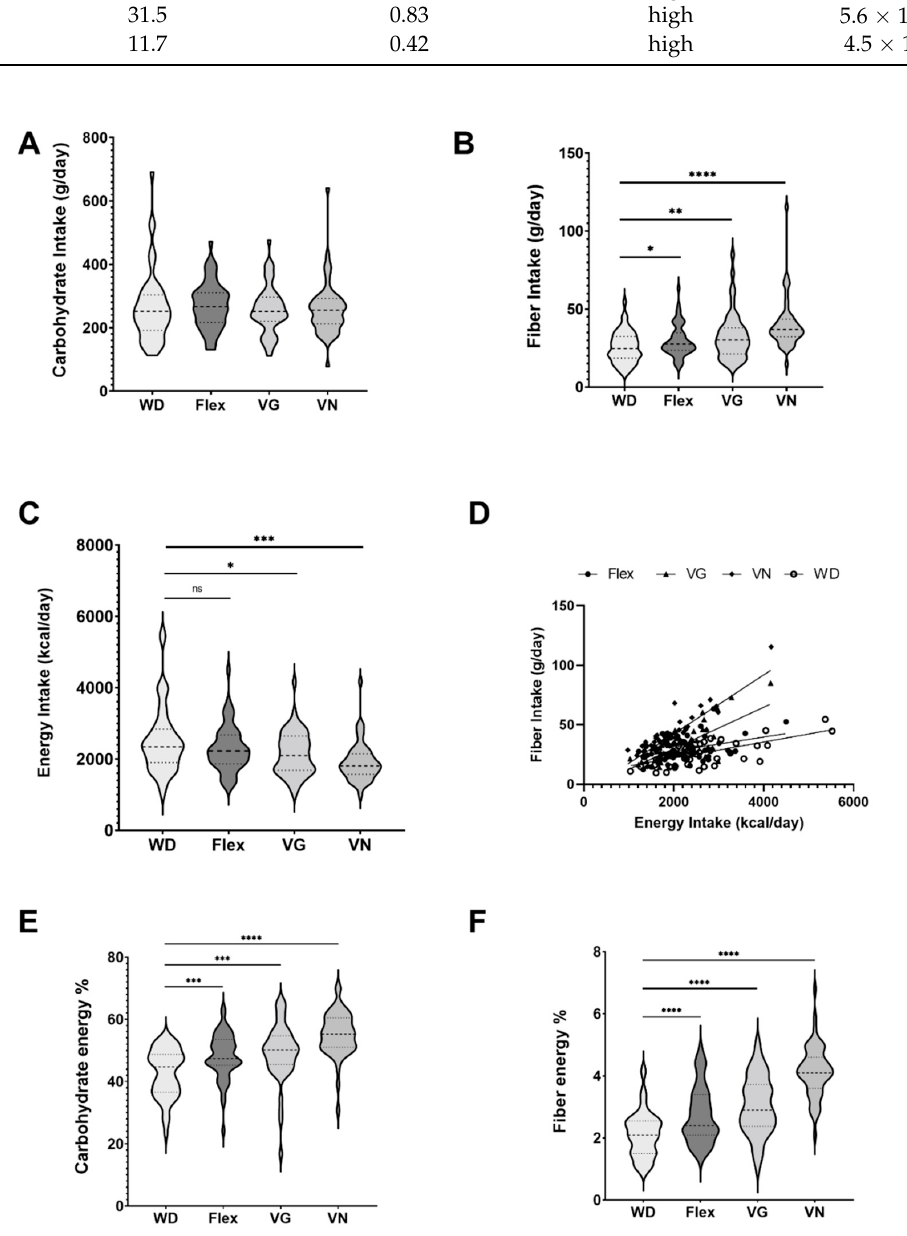
Figure 3. Di ff erences in carbohydrate and fi ber intake (g/day) as well as energy intake (kcal/day) for Figure 3. Differences in carbohydrate and fiber intake (g/day) as well as energy intake (kcal/day) for each dietary group ( A – C ). Regression of energy intake and fi ber intake ( D ). Percentage of daily en- each dietary group ( A – C ). Regression of energy intake and fiber intake ( D ). Percentage of daily energy ergy consumption of carbohydrates ( E ) and fi ber ( F ); ns: not signi fi cant, *: p < 0.05, **: p < 0.01, ***: p consumption of carbohydrates ( E ) and fiber ( F ); ns: not significant, *: p < 0.05, **: p < 0.01, ***: p < 0.001, < 0.001, and ****: p < 0.0001. and ****: p < Table 5. One-way ANOVA test of energy intake, carbohydrate intake, and fi ber intake across all dietary forms.